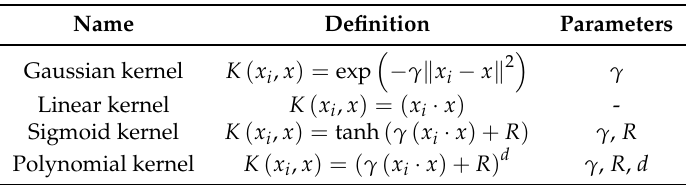
Table 1. Admissible kernel